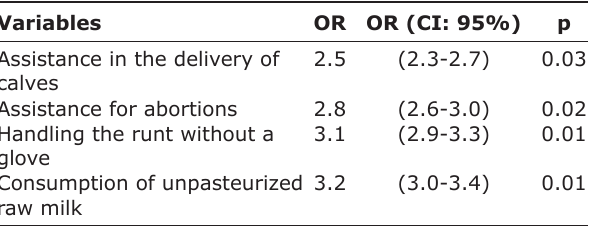
Table-5: Risk behaviors observed among sheep and goat farmers in the Province of Bam in Burkina Faso, 2021. Variables